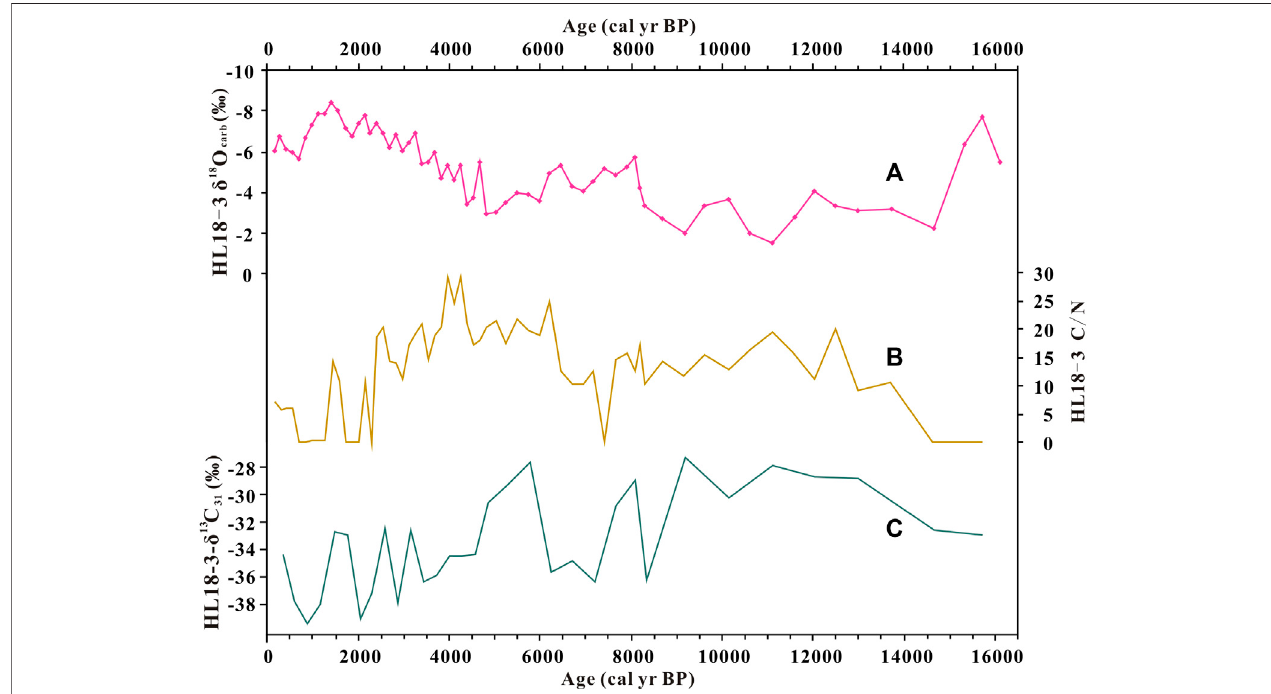
FIGURE 5 | Climate proxies derived from the HL18-3 core. (A) The δ 18 O carb in the HL18-3 core. (B) The C/N ratios in the HL18-3 core. (C) The n-alkanes derived δ 13 C 31 in the HL18-3